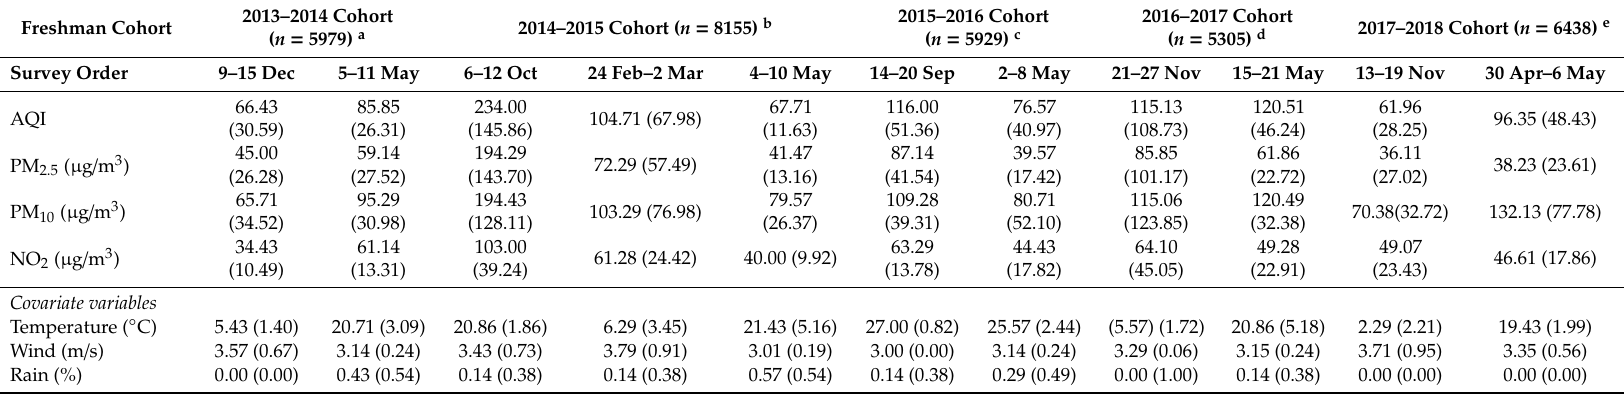
Table 3. Average air pollution concentrations and other environmental variables in the last seven days before survey ( n = 31,806).